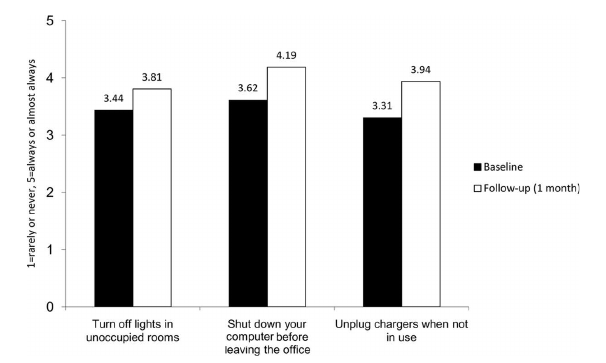
after the Turn It Off campaign ( M = 3.68) compared to before ( M = 3.28). The eta squared statistic ( η 2 = 0.23) indicated